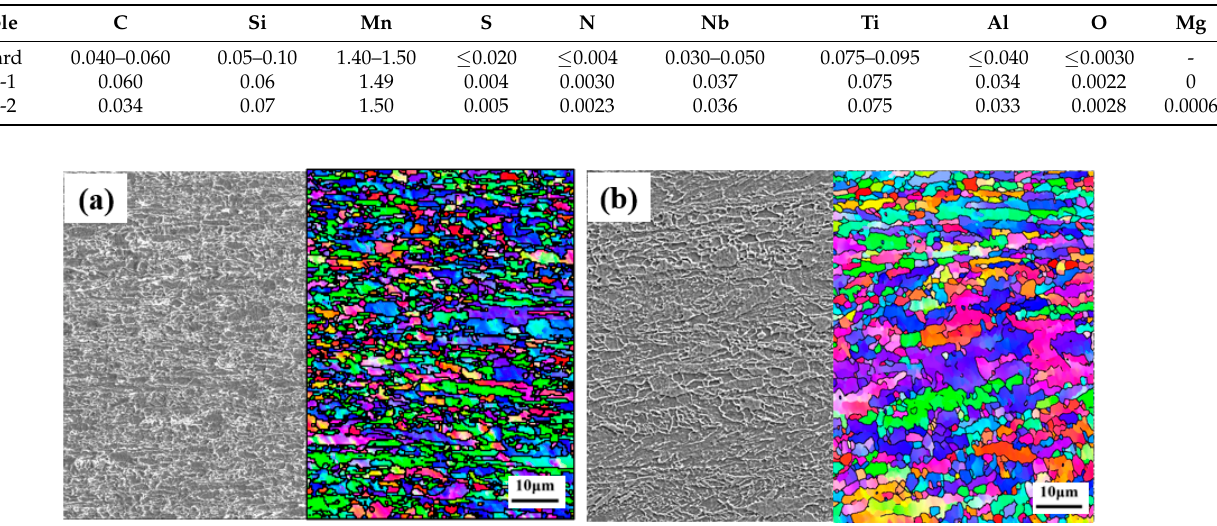
Table 1. The chemical compositions of the experimental steels (wt.%).